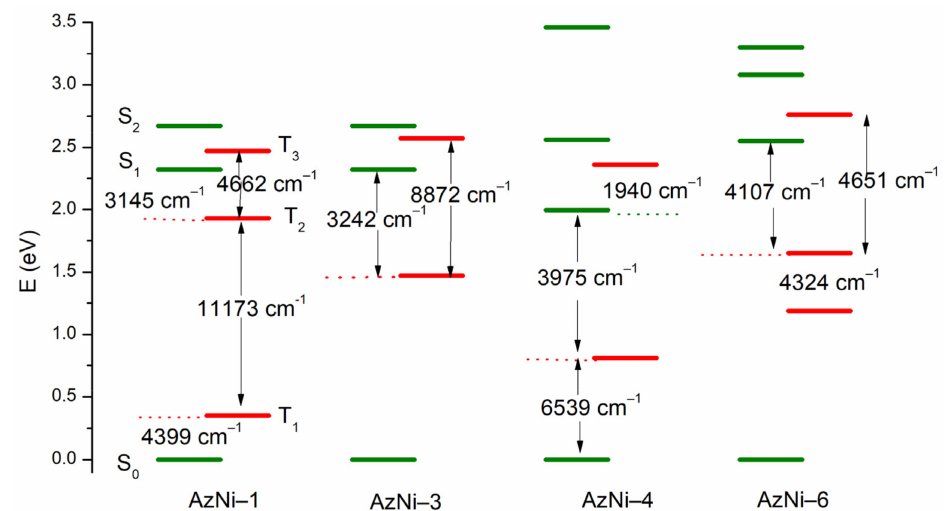
Figure 5. Low-lying energy states in AzNI-1, AzNI-3, AzNI-4, and AzNI-6 molecules.